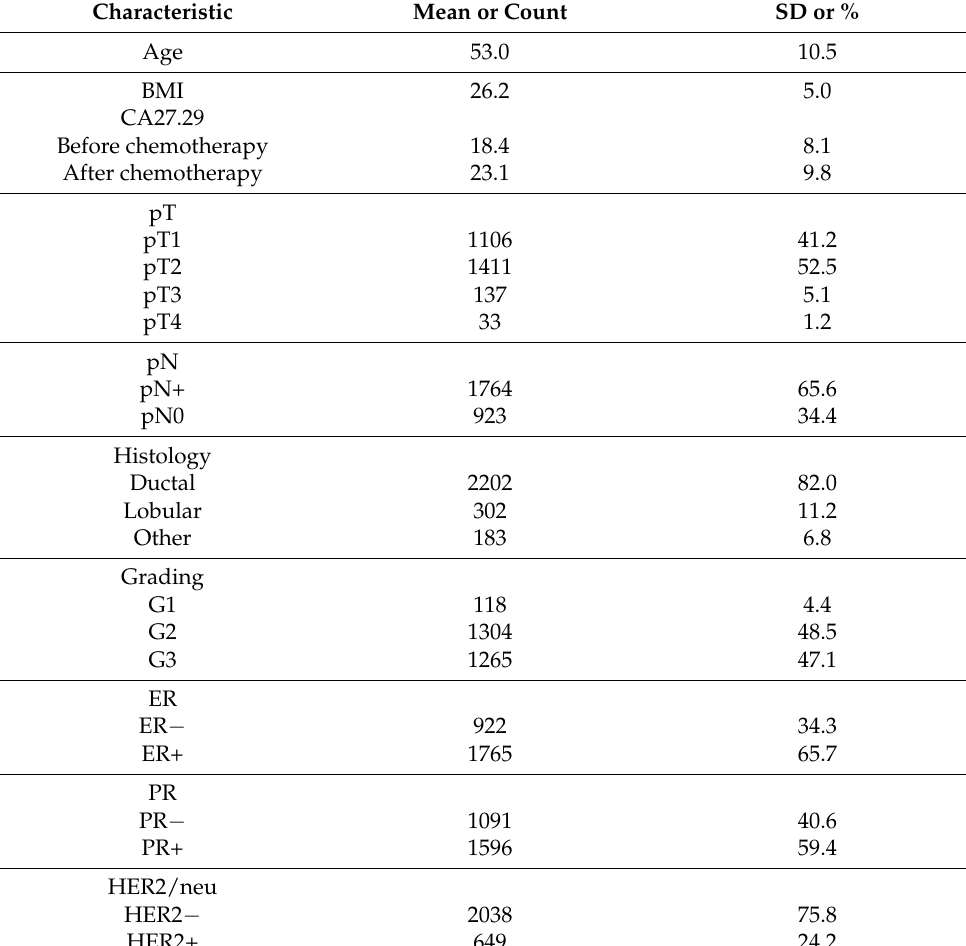
Table 1. Patient